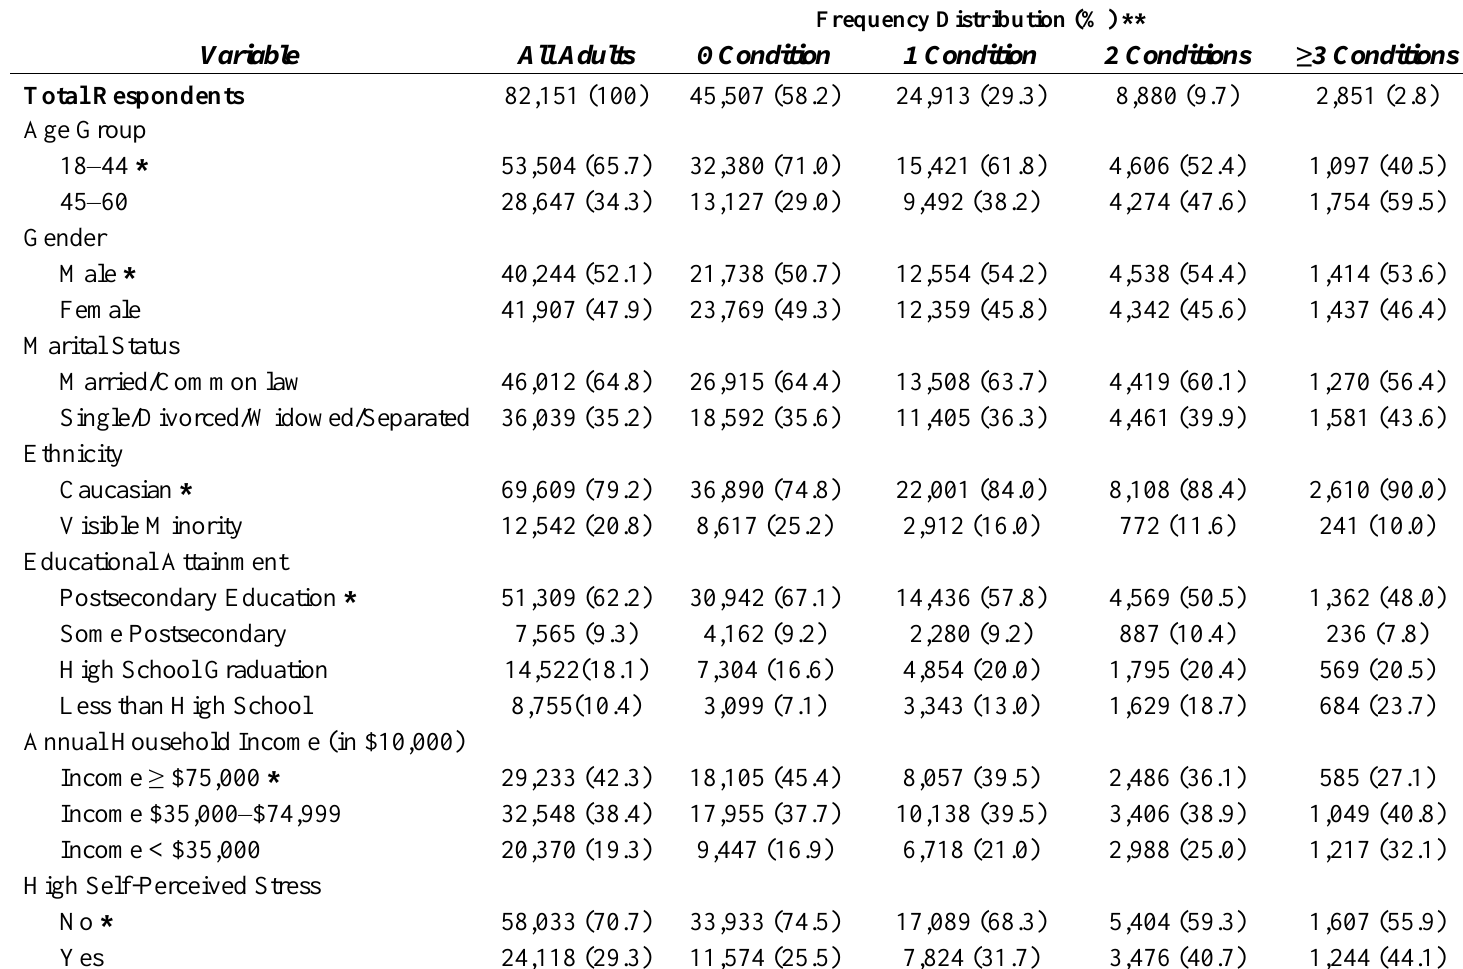
Table 1. Descriptive statistics for respondents aged 18–60 by number of compound health problems. Canada 2000–2005 (n =